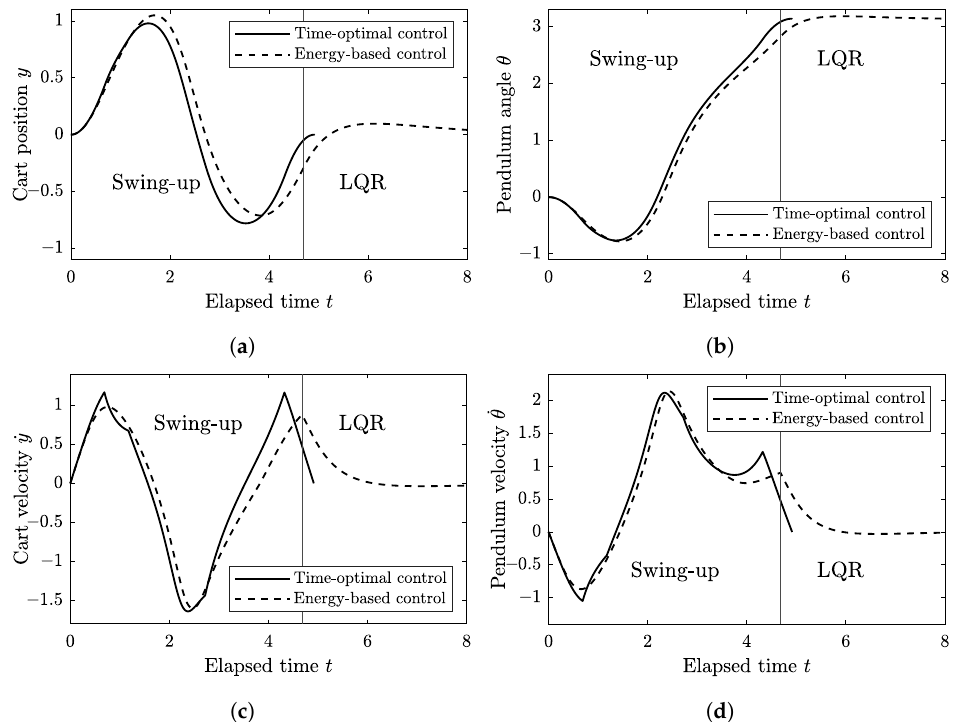
Figure 7. Comparison of the optimal time solution (solid line) with that found using the energy-based control strategy (dashed line). The vertical solid lines denote the end of the swing-up phase for the energy-based